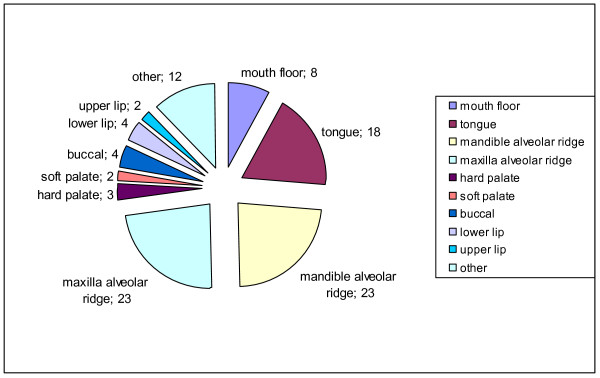
Location of tumors.